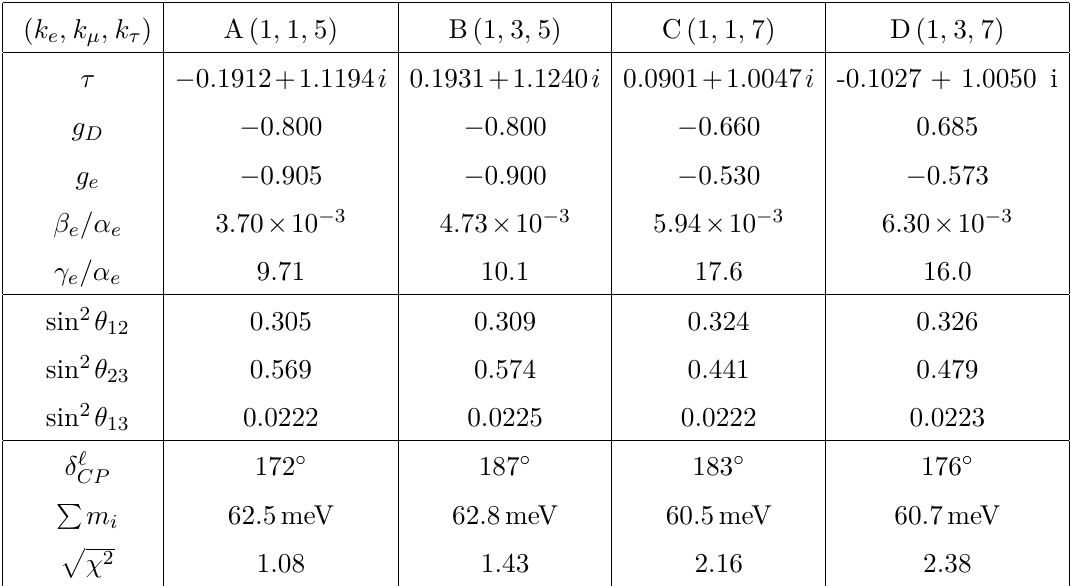
Table 3 . Numerical values of parameters τ , g D , g e , β e /α e , γ e /α e and output of best fitting three mixing angles. The CP violating Dirac phase δ ‘ and the sum of three neutrino masses P m i are CP predicted. The square root of the sum of χ 2 are also